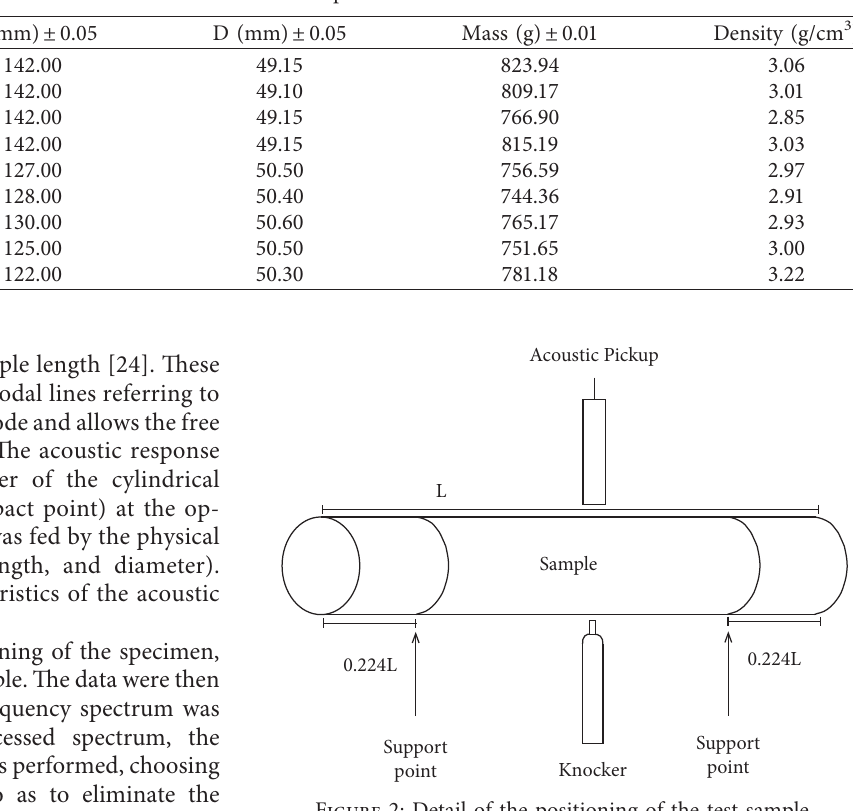
Table 2: Dimensions of the specimens.